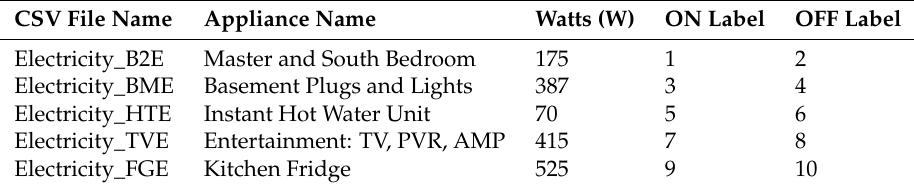
Table 10. Five appliances information in AMPds2 dataset selected